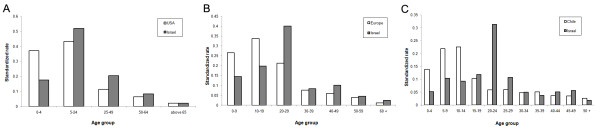
Age distribution of cases in different countries. Standardized rates of swine flu in different age classes and different countries. The number of cases in each age class is divided by total population in these ages, and these rates are later divided by the sum of all of the rates in all age classes. These rates were calculated for the USA - A (confirmed cases from the 15/4-24/7/2009 Based on [55]), Europe - B (confirmed cases up to the 20/7/2009 based on [17]) and Chile - C (all confirmed cases up to the 2/7/2009 based on [7]) and compared to their parallel rates in Israel.